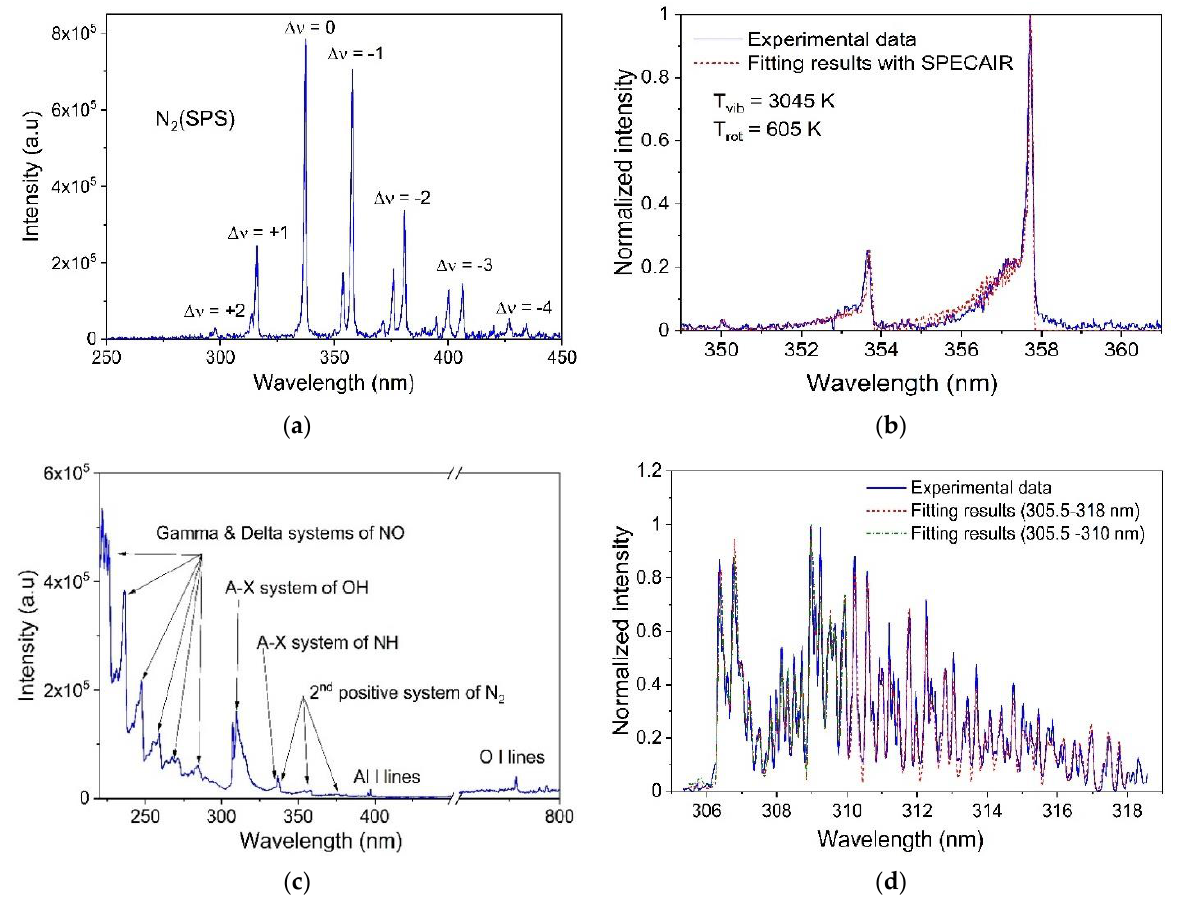
Figure 2. Optical emission spectra of air DBD and dry air Gliding Arc discharges: ( a ) wide-band emission spectrum (250 – 450 nm) and ( b ) comparison between experimental and theorical spectrum using Specair ® software for the Δν = −1 vibration band of the 2nd positive system of N 2 in air DBD; ( c ) wide-band emission spectrum (220–800 nm) and ( d ) comparison between experimental and theoretical spectrum using Specair ® software for the rovibration structure of the A-X transition of OH radical in air Gliding Arc discharge.